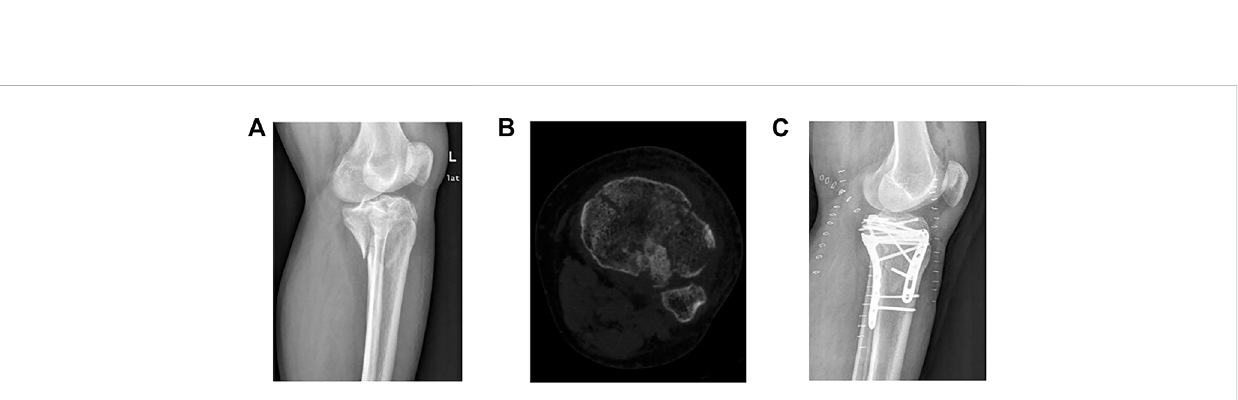
Imaging examinations of the affected limb before and after surgery. (A) Preoperative lateral X-ray of the affected limb, showing posterolateral fracture fragments. (B) Transverse CT of the affected limb, showing fracturesof the lateral, medial, and posterior columns. (C) Postoperative lateral X-ray of the affected limb, showing good joint surface reduction and fracture fi xation.